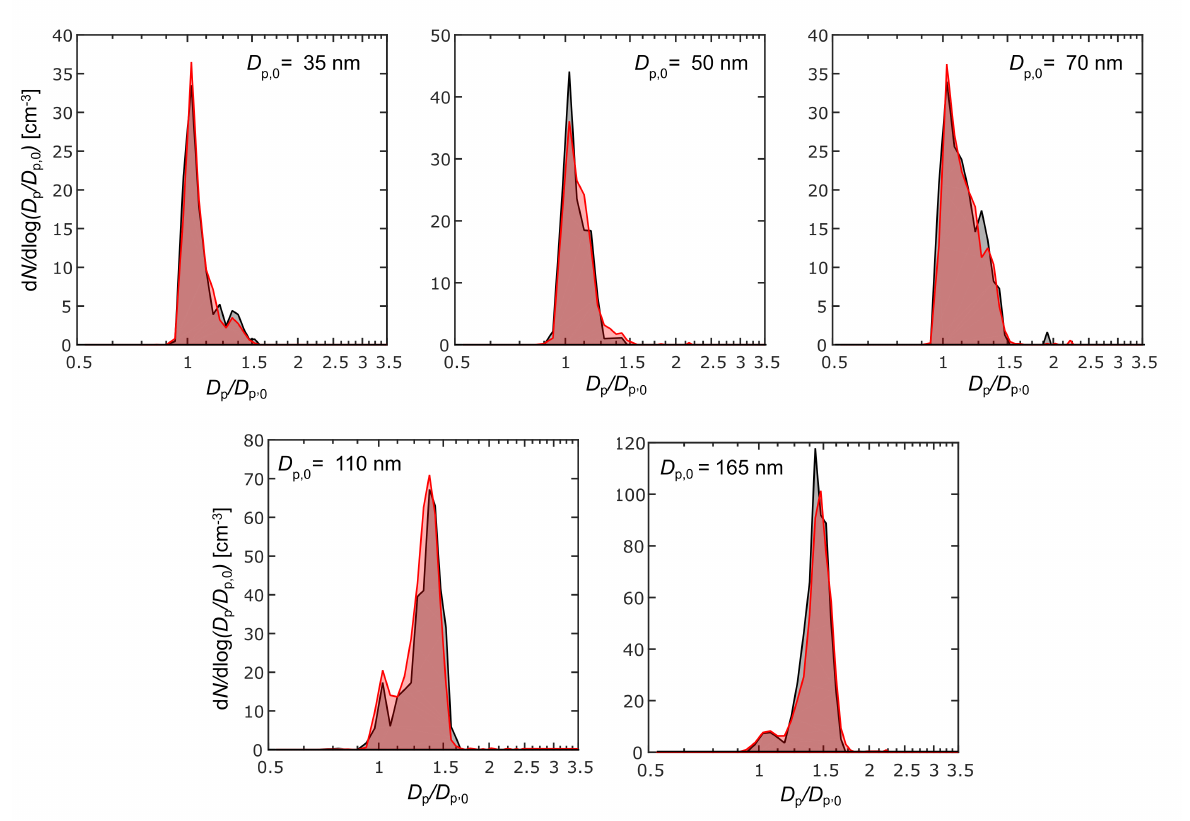
Figure 10. Comparison of GF distributions of size-selected ambient particles humidified to 85% for short (20s, black) and long (200s, red) sampling